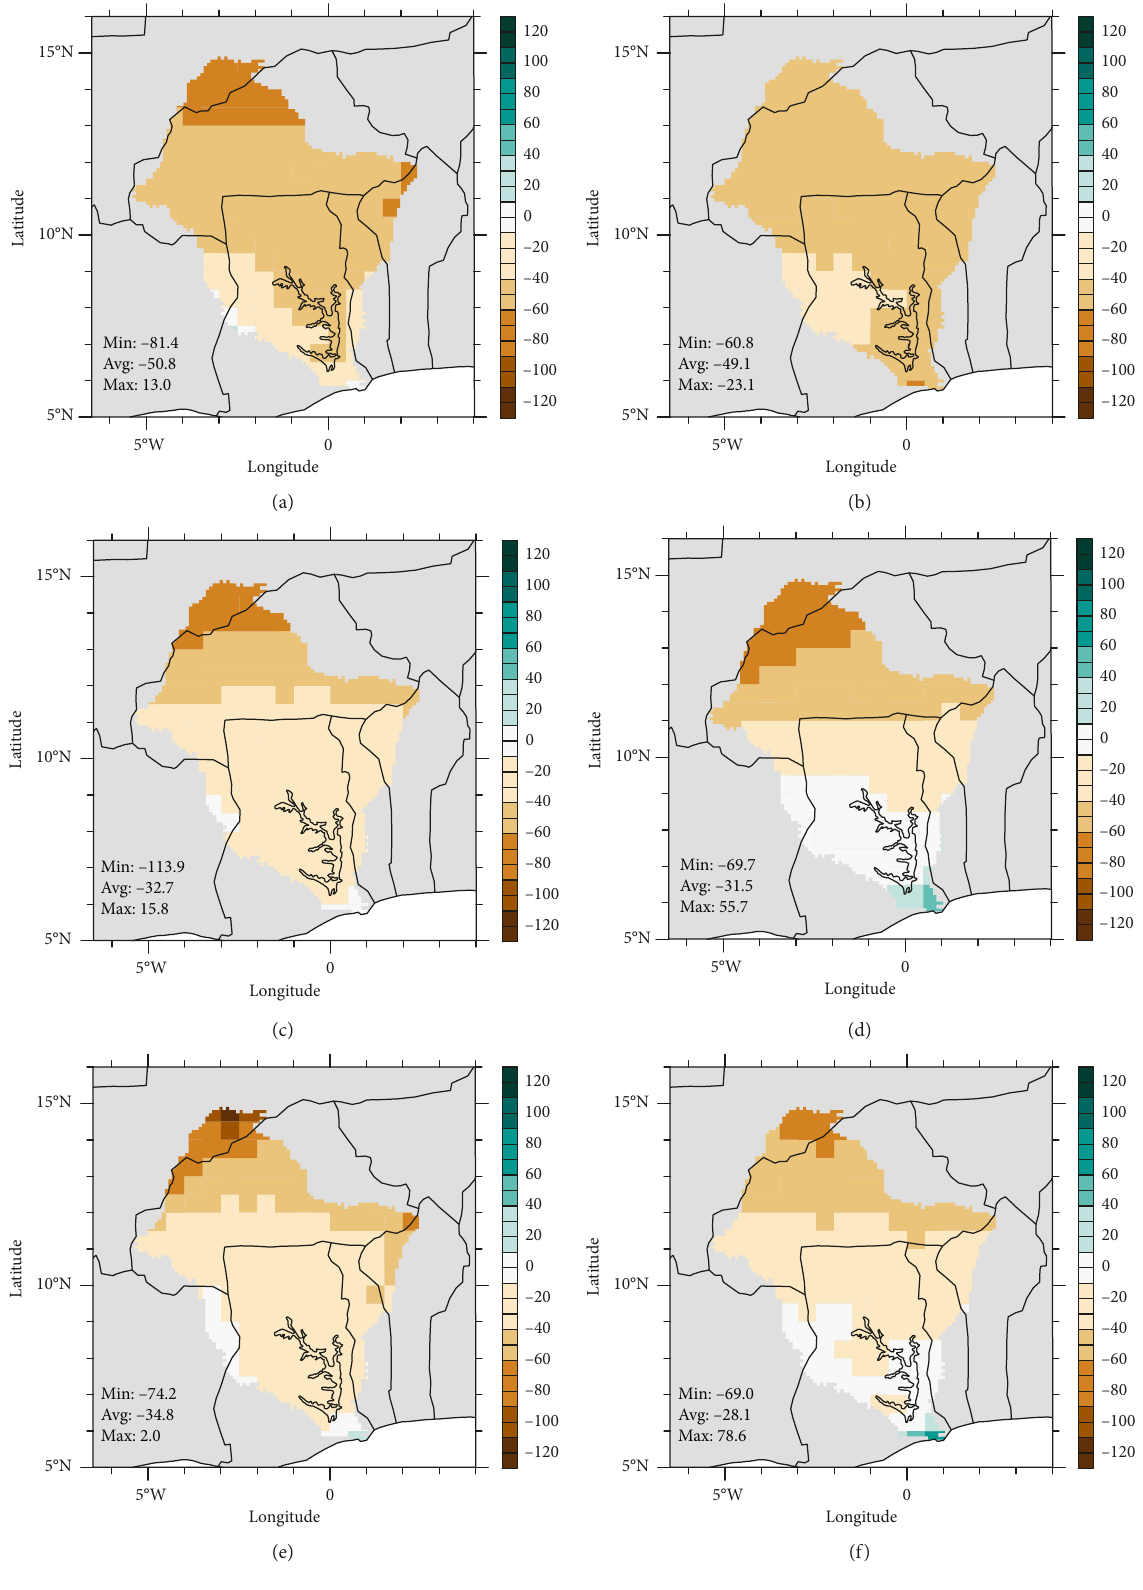
Figure 3: The climatological (1950–2004) mean bias in the annual total precipitation for the models: MRI-CGCM3 (a), INMCM4 (b), HadGEM2-CC (c), IPSL-CM5A-MR (d), HadGEM2-AO (e), and CMCC-CM (f), underestimating the observed climatological mean over major parts of the Volta